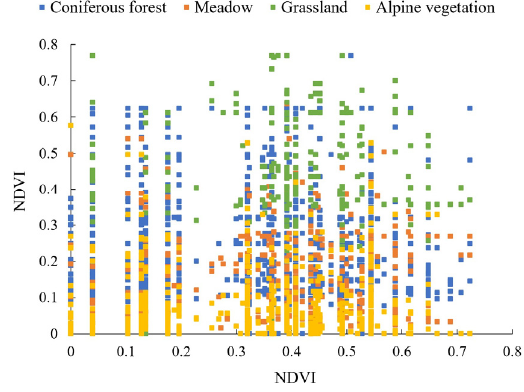
Figure 12. Distribution of NDVI by vegetation cover.